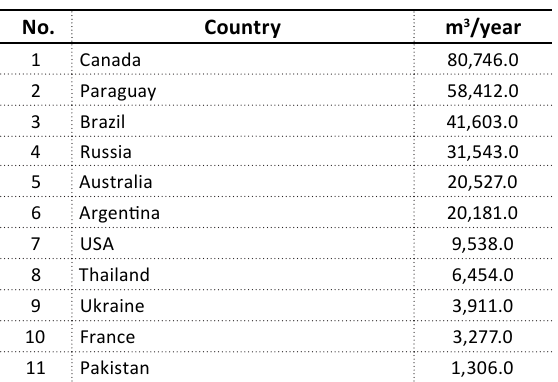
Table 5. Water supply index for influential countries Table 6. Water supply index for individual